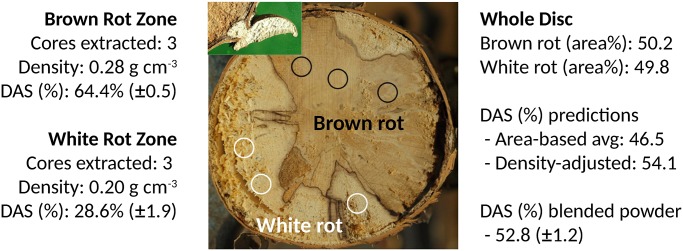
Density bias.A single disc from a standing birch tree (~15cm dia) was cut, air-dried, and sanded (photo). The brown rot zone was obvious, located not only by color but by having a Piptoporus betulinus sporophore emerging (inset) on the adjacent disc. Similar was done in the white rot zone using a Fomes fomentarius sporophore. Triplicate cores show the density disparity along with DAS. Milling and homogenizing the whole disc, the actual DAS was higher than predicted based on area%, due to the biasing effects of higher brown rot density.